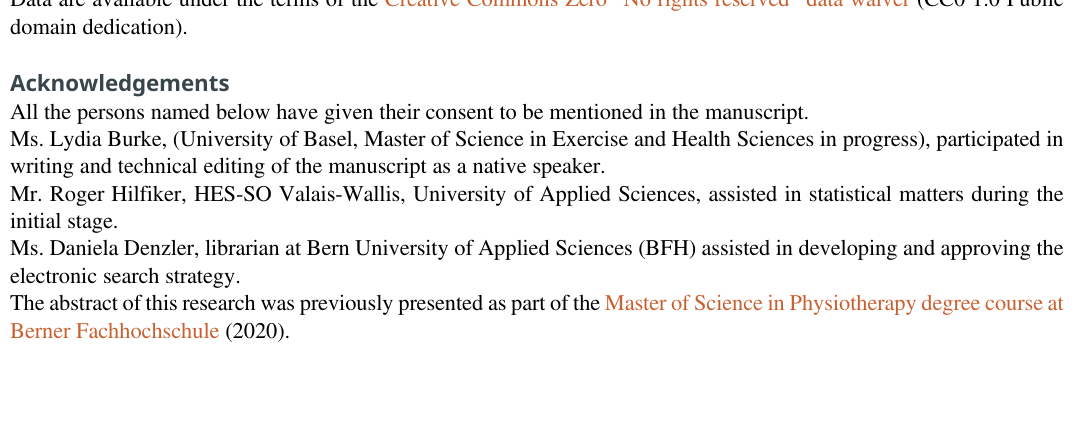
Figshare: Appendix F